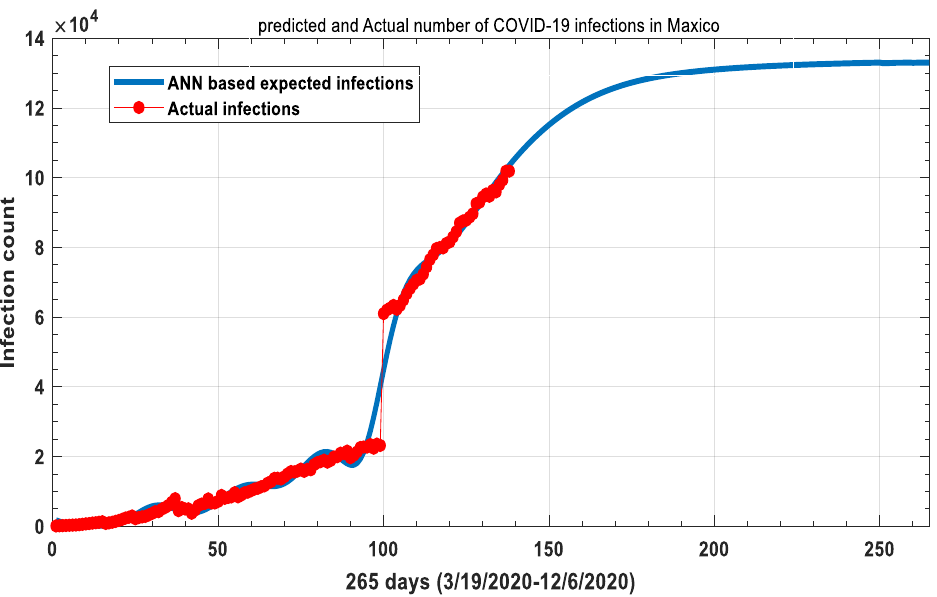
Figure 7. The training data and predicted data of COVID-19 infected people in Mexico.